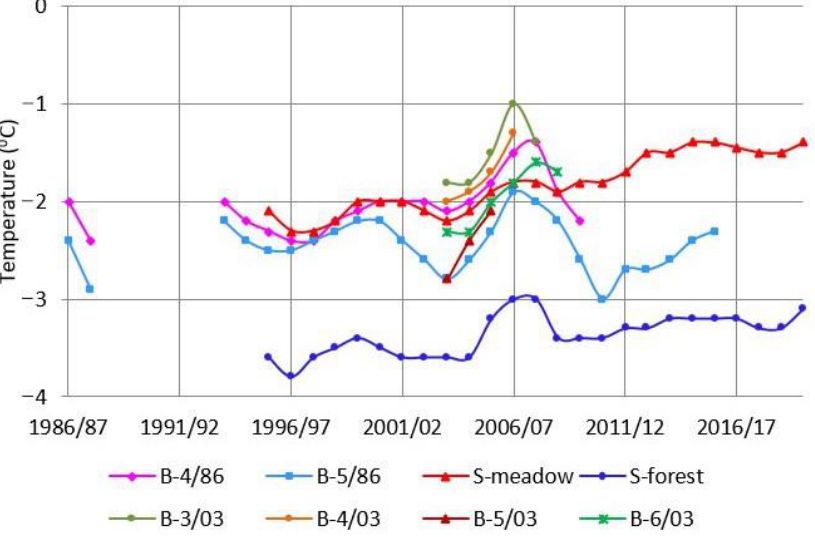
Figure 12. Long-Term variability in the mean annual ground temperature at a depth of 10 m on the experimental plots of the above-floodplain – low-terraced type of terrain (Tuymaada Valley). While the ground temperature of the layer of zero amplitude is characterized by a high interannual variability, the same cannot be said about the active layer thickness (ξ)— one of the main indicators of the thermal state of the upper layer of permafrost. Over the past 24 years, the value of ξ in the meadow varied within 1.82– 1.90 m, averaging 1.86 m. In the forest, ξ changed from 1.77 m to 1.90 m, averaging 1.84 m. In general, for the period 1996 – 2019, the trends in the increase in active layer thickness were insignificant, and amounted to 2 cm/10 years in the forest and 1.8 cm/10 years in the meadow (Figure 13). For comparison, from 1968 to 1976, ξ in the meadow varied from 1.73 to 1.95 m [17], and the interannual variability was greater than in the last 24 years.